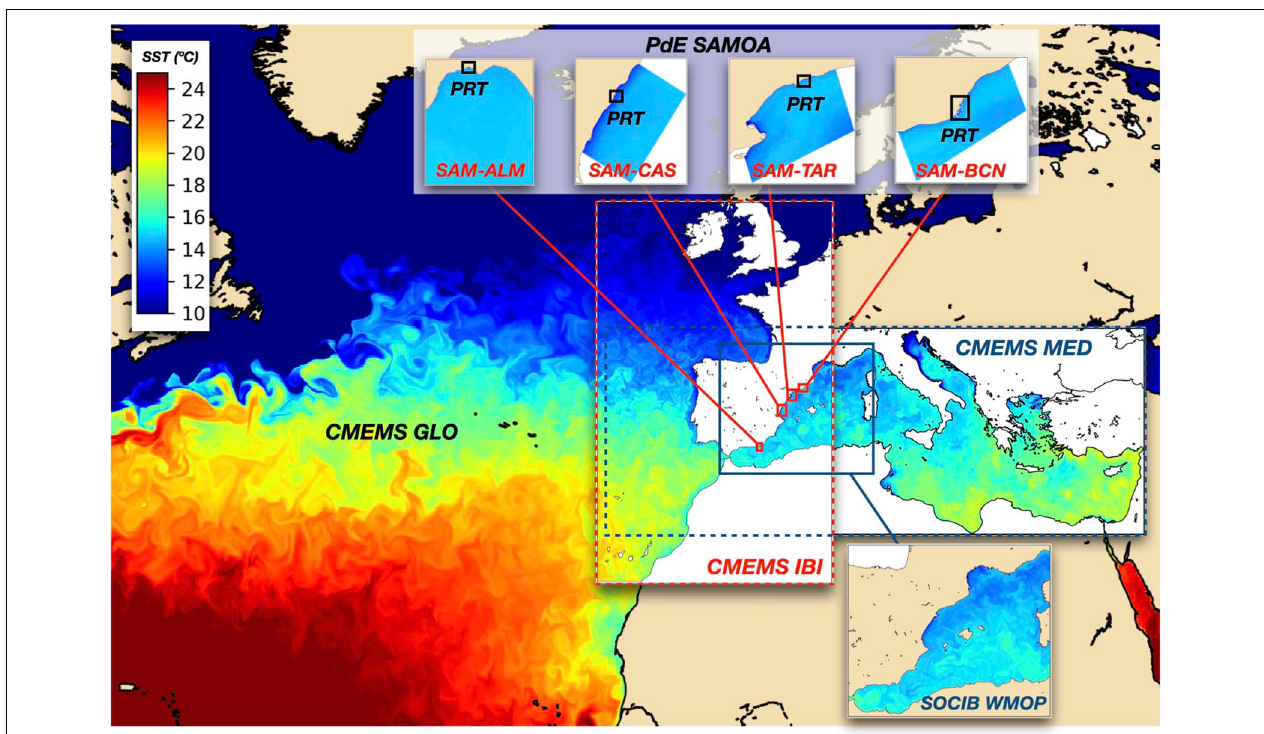
FIGURE 3 | Map of CMEMS (GLO, IBI, and MED) and CMEMS-downstream (SOCIB WMOP and PdE SAMOA) operational ocean forecasts in the area. Links between forecast services are depicted: CMEMS regional IBI and MED systems nest into the GLO one. Coastal systems nested into CMEMS IBI and MED are depicted in red and blue,